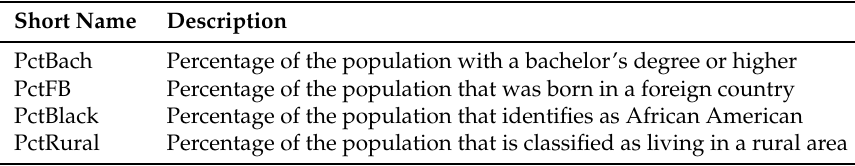
Table 1. Georgia dataset.